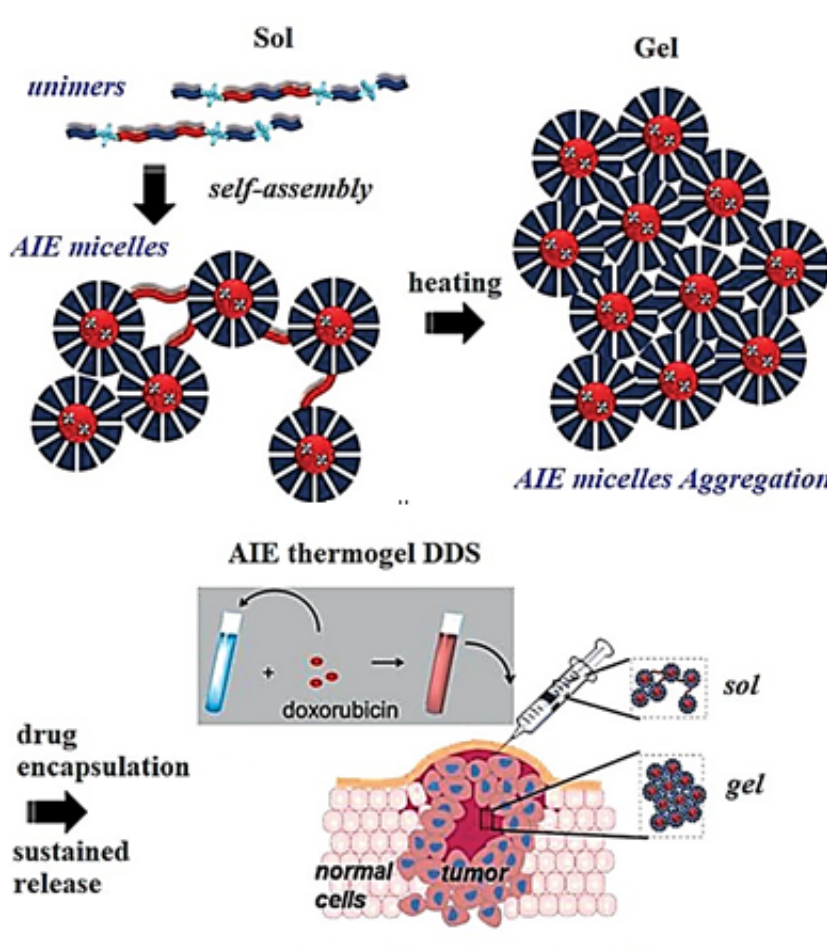
Figure 25. Schematic representation of unimers, AIE-active micelles, aggregation of a micelle, and in-situ gelling of drug delivery system. Reprinted from reference [136] with the permission of Wiley-VCH.